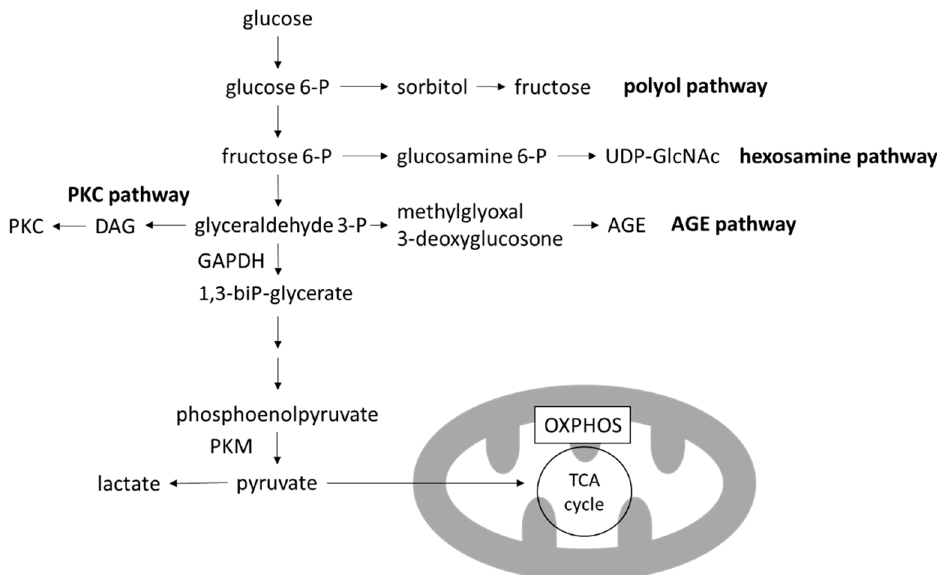
Figure 3. Glycolysis and branching pathways. In the high-glucose environment of DKD, glycolysis is increased and OXPHOS is decreased, leading to the accumulation of toxic metabolites produced in the branching pathways of glycolysis. AGE, advanced glycation end-product; DAG, diacylglycerol; GAPDH, glygeraldehyde-3-phosphate dehydrogenase; OXPHOS, oxidative phosphorylation; PKC, protein kinase C; PKM, pyruvate kinase M; TCA cycle, tricarboxylic acid cycle; UDP-GlcNAc, uridine diphosphate N-acetylglucosamine.